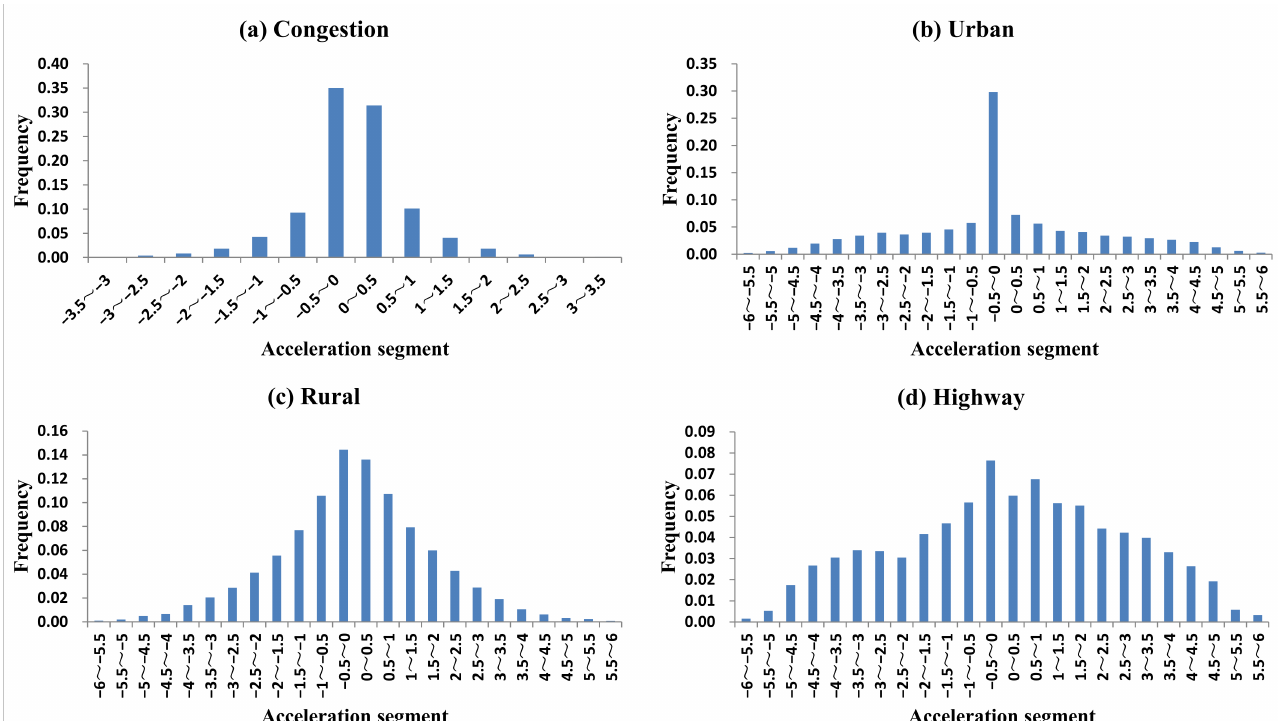
Figure 13. The distribution of acceleration frequent terms in congestion, urban, rural, and high- way